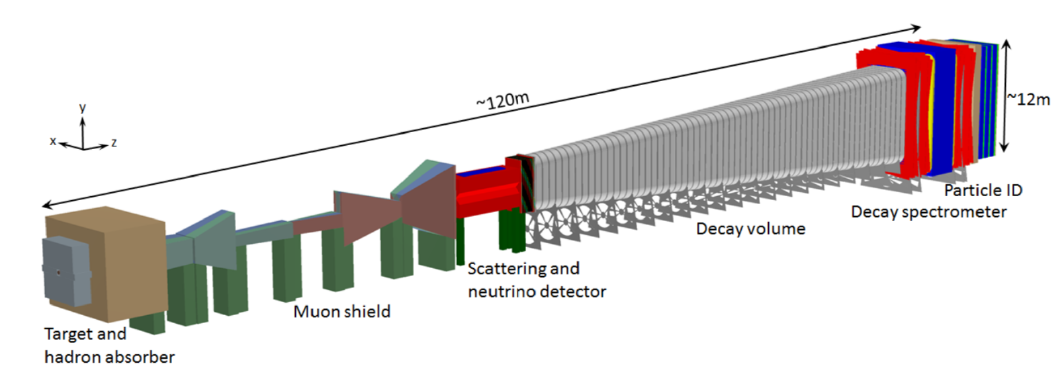
Figure 1. Layout of the SHiP facility.